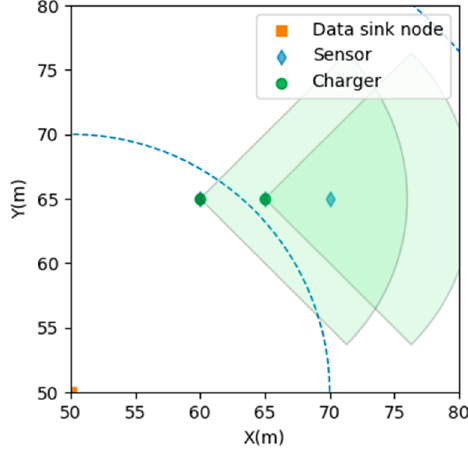
Figure 3. Covers all sensors with two chargers.